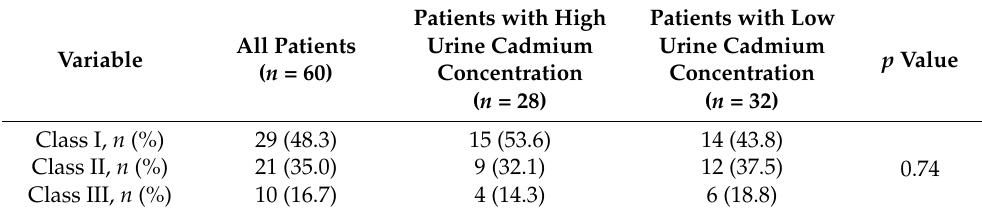
Table 2. Sagittal skeletal relationship of orthodontic patients, stratified according to their urine cadmium concentrations as high or low ( n = 60).